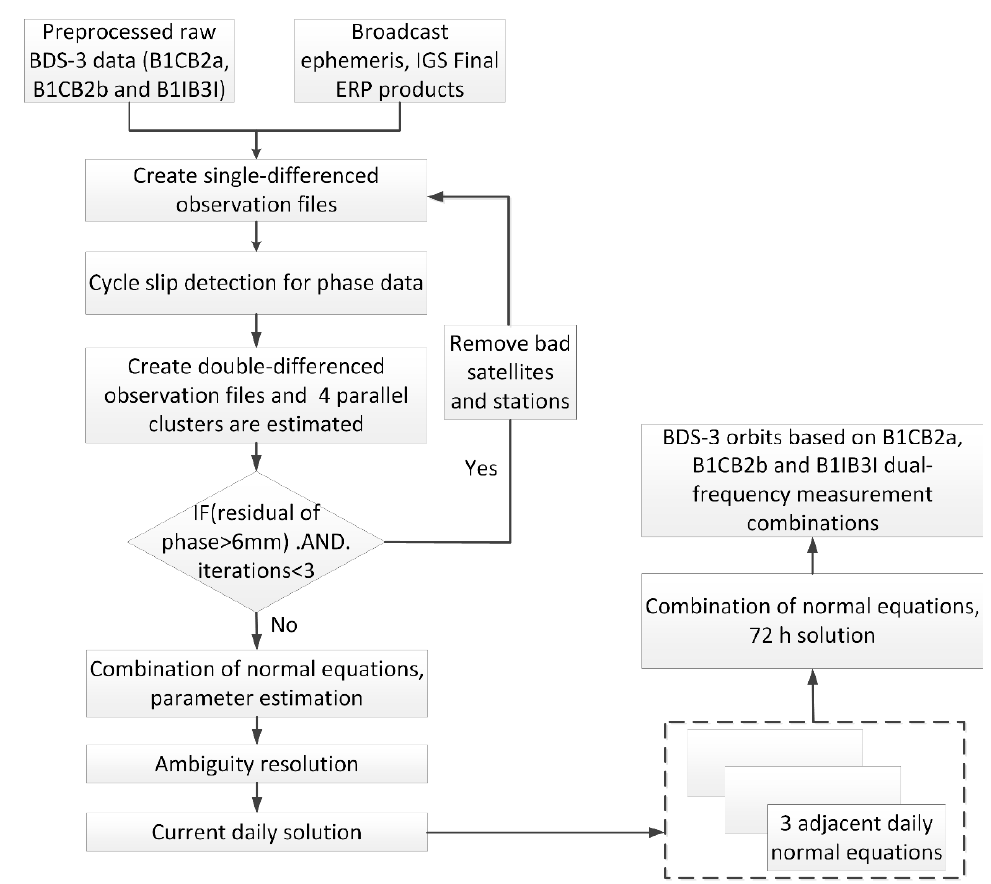
Figure 2. Flowchart of BDS-3 POD procedure based on B1CB2a, B1CB2b and B1IB3I dual-frequency measurement combinations.